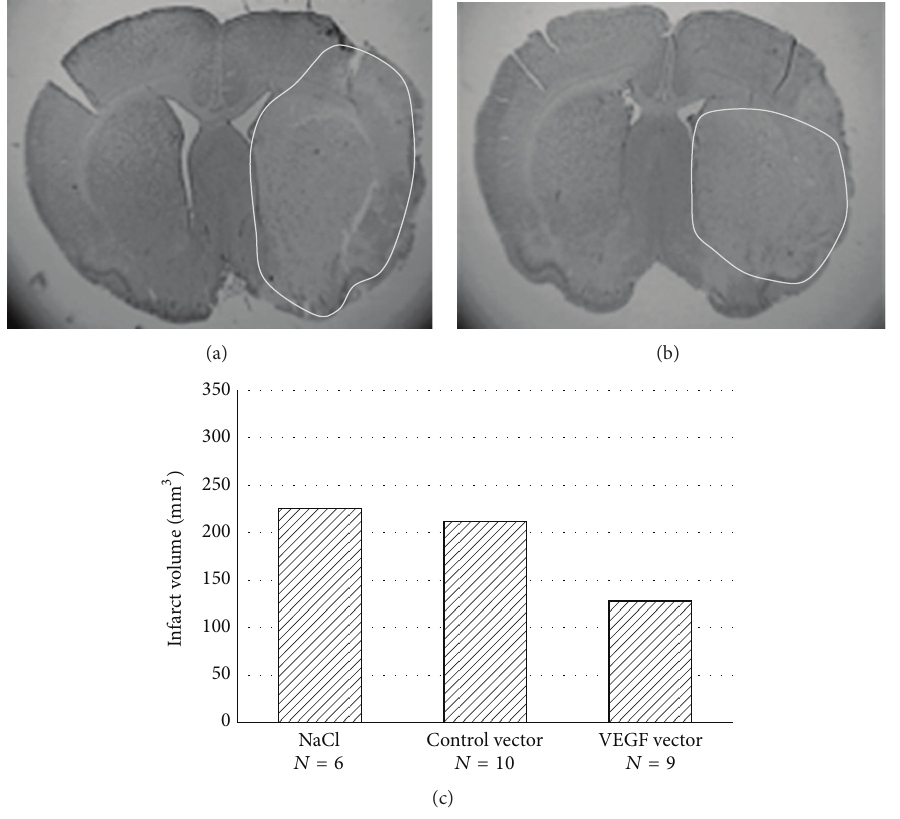
Figure 1: Cresyl violet staining after 45 minutes of tMCAO and 24 h reperfusion time. (a) Distinct ischemic brain injury after i.m. injection with saline. (b) Attenuated ischemic brain injury after i.m. injection with VEGF. (c) Infarct volume in the three different groups in mm 3